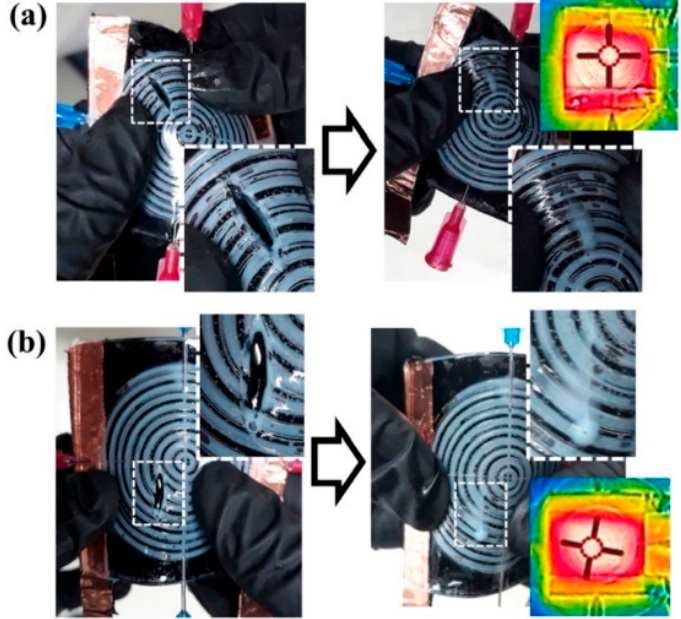
Figure 16. Self-healing of different cracks oriented at ( a ) 45 ◦ and ( b ) 90 ◦ [117]. Reproduced with permission from Kim, H; Polymer; published by Elsevier, 2019.